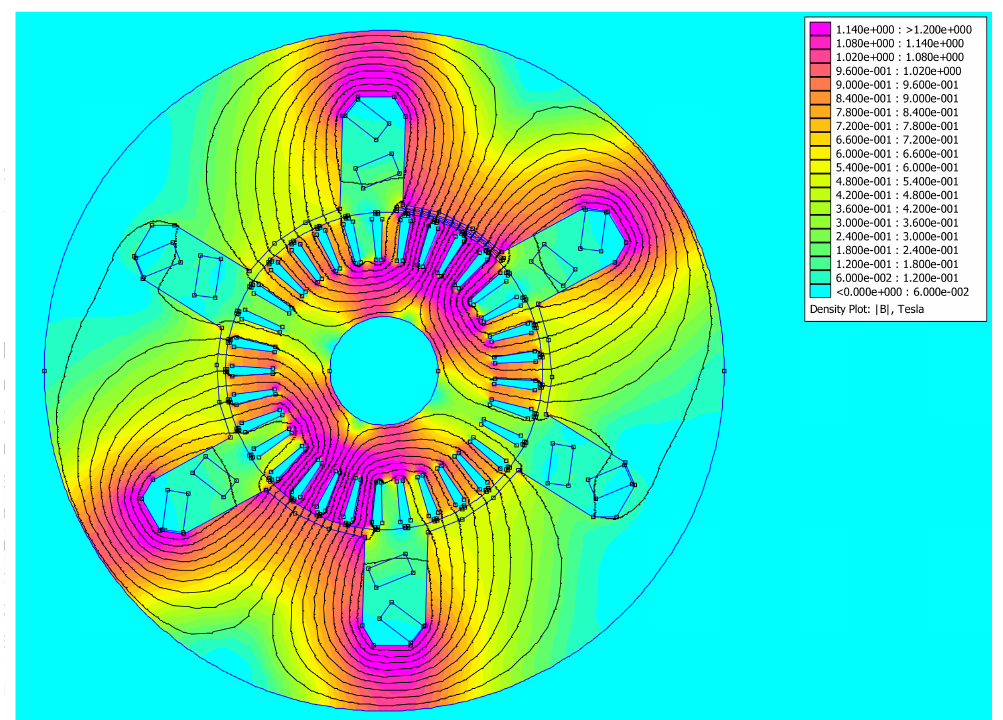
Figure 12. Flux density plot of motor at peak on phase